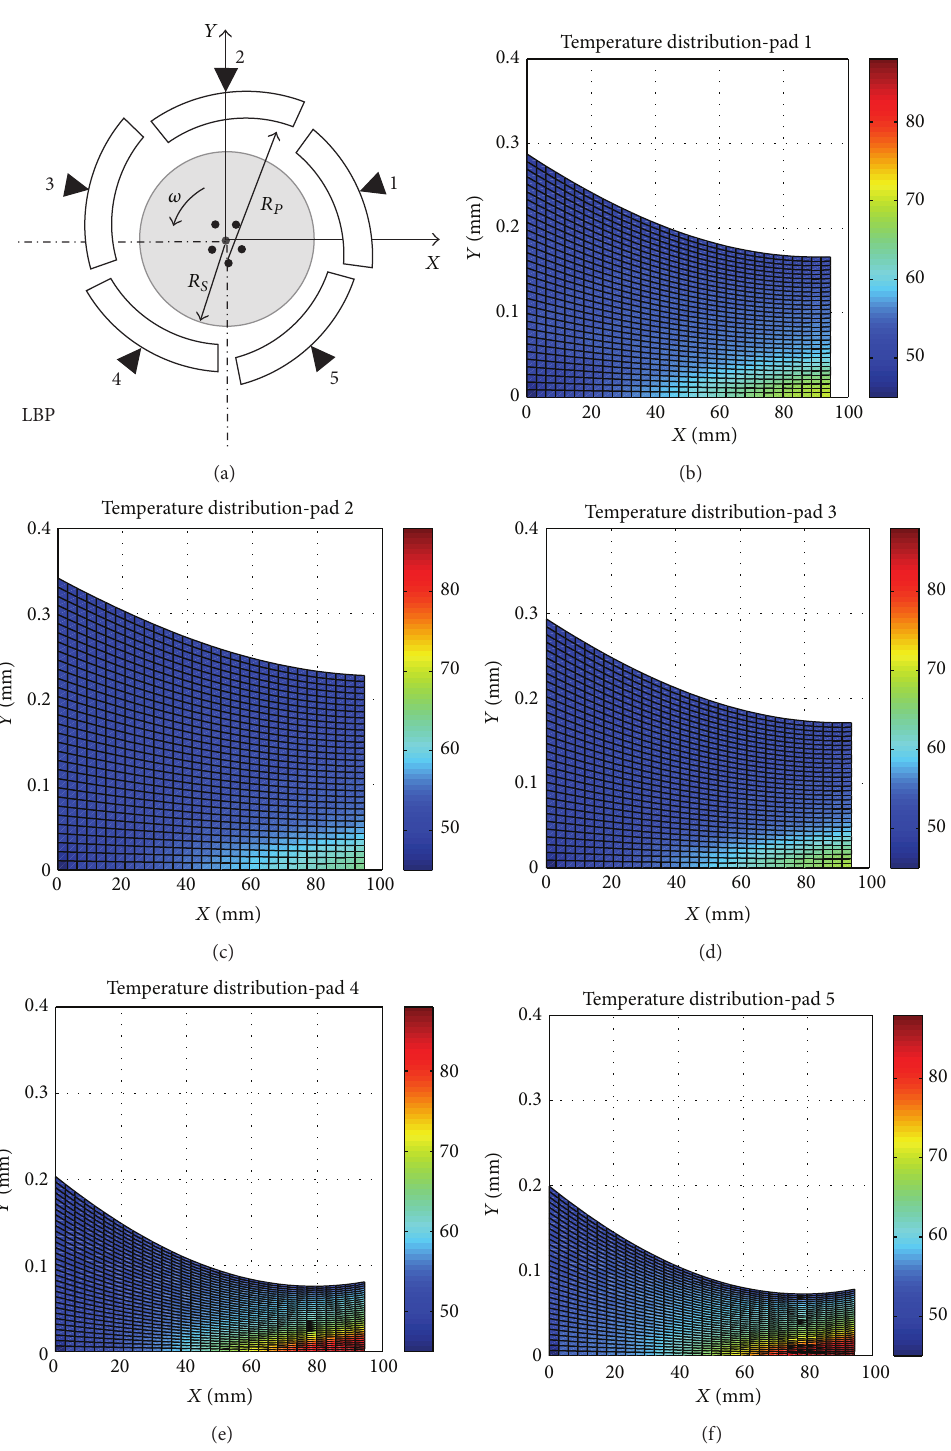
Figure 13: Temperature distribution on the pads obtained from the lower radial clearance and the maximum rotational speed: (a) bearing configuration; (b) pad 1; (c) pad 2; (d) pad 3; (e) pad 4; (f) pad